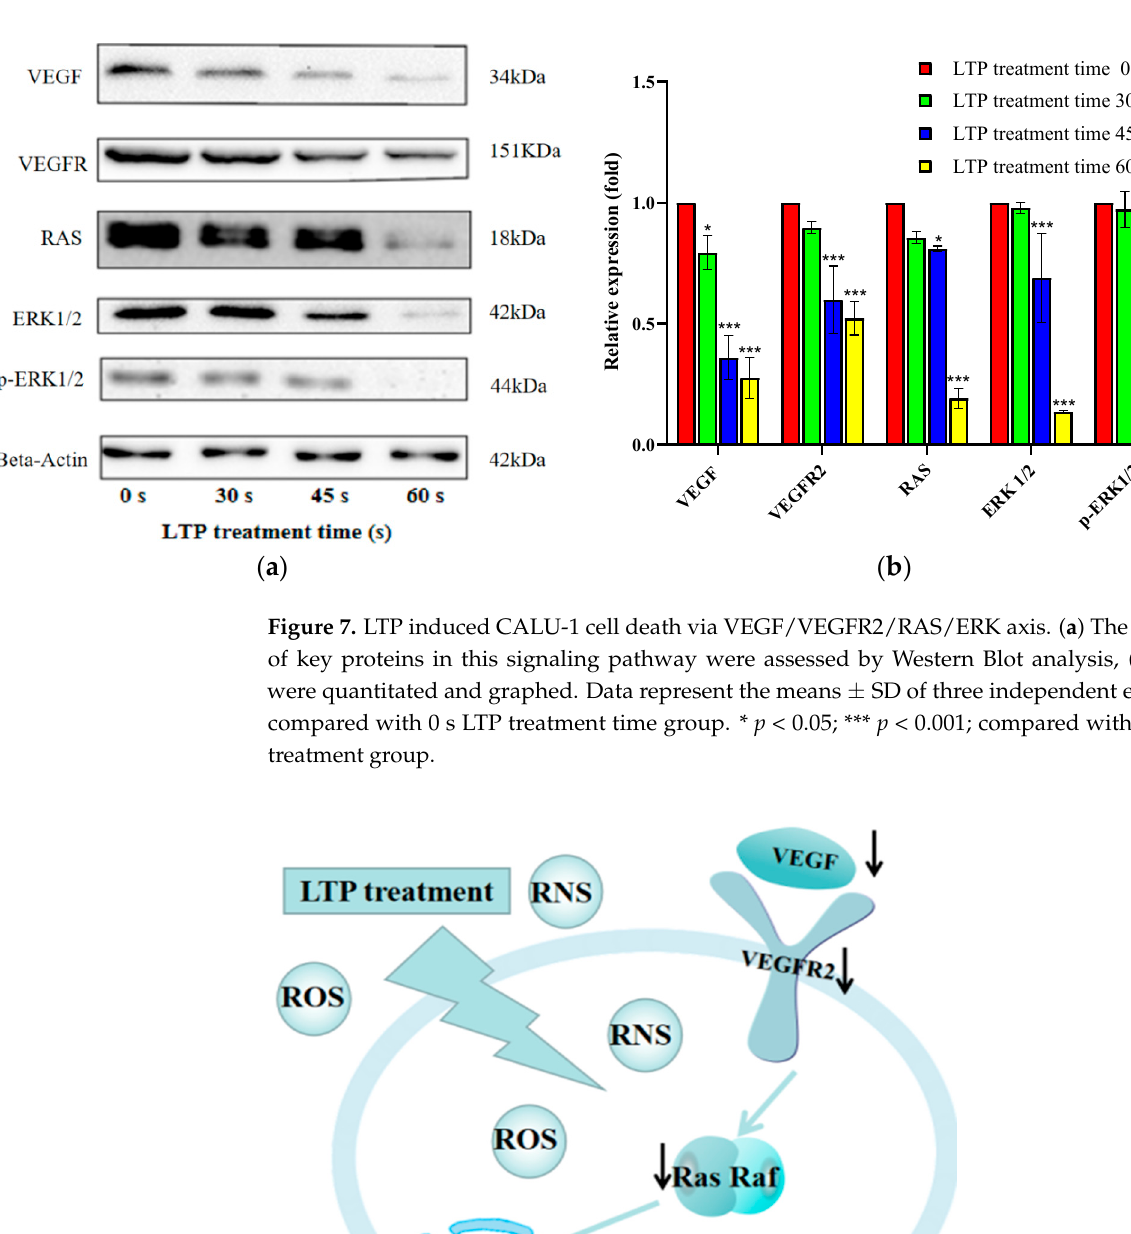
Figure 8. LTP can generate ROS and RNS and suppress the growth of lung cancer cells via inhibition of the VEGF/VEGFR2/RAS/ERK axis. Black arrows in the figure denote proteins with reduced expression following LTP treatment.